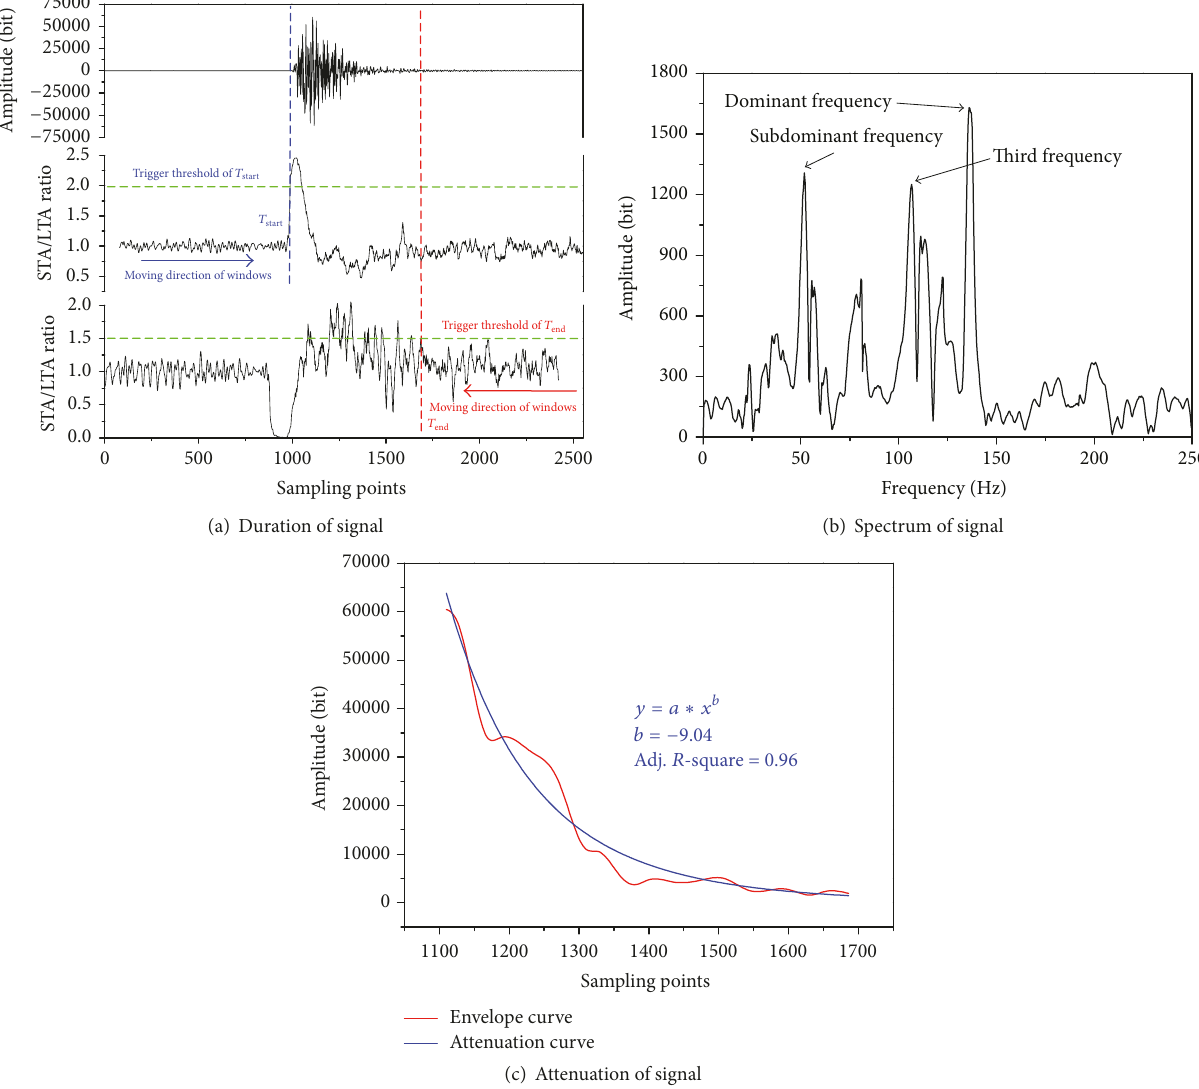
Figure 12: Signal characteristics of sensor S3 for the blasting